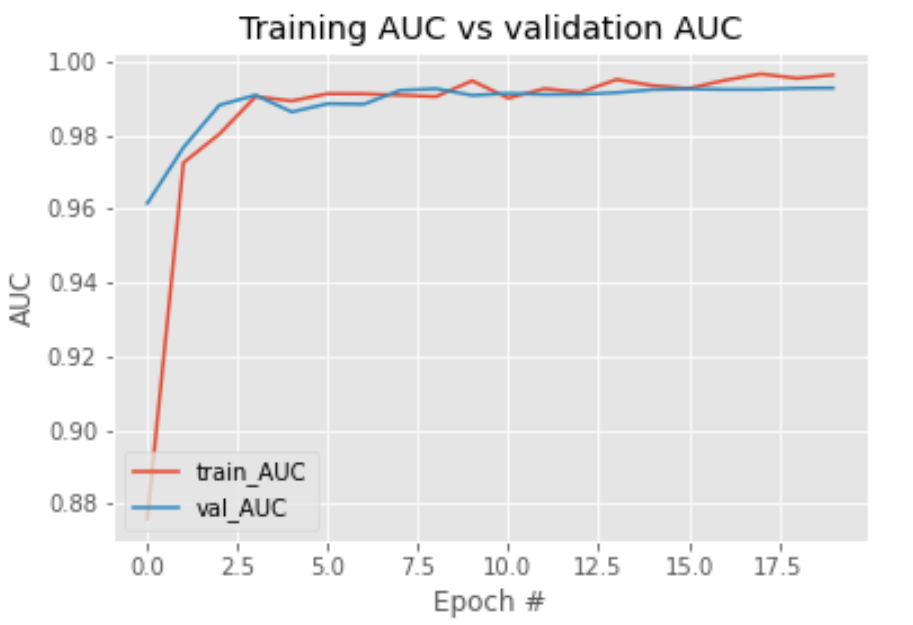
Figure 10. Training and validation AUC ROC curve. Table 4. Confusion matrix of classification.